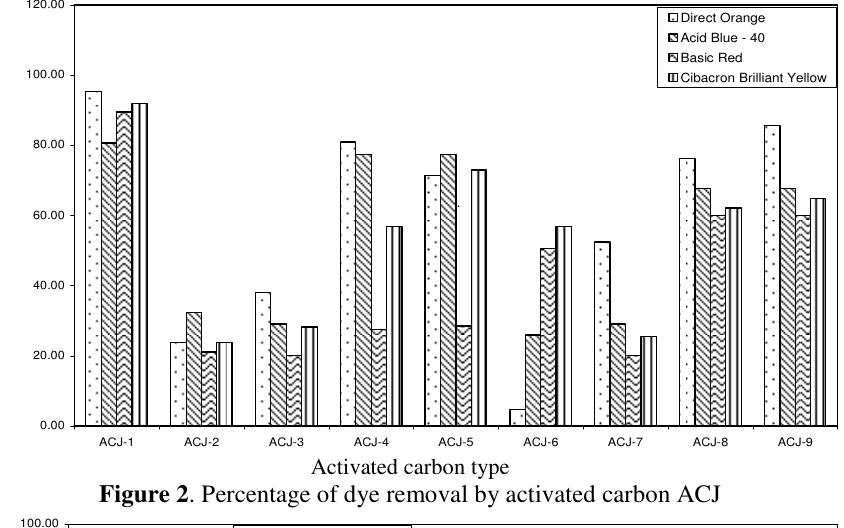
Figure 2 . Percentage of dye removal by activated carbon ACJ